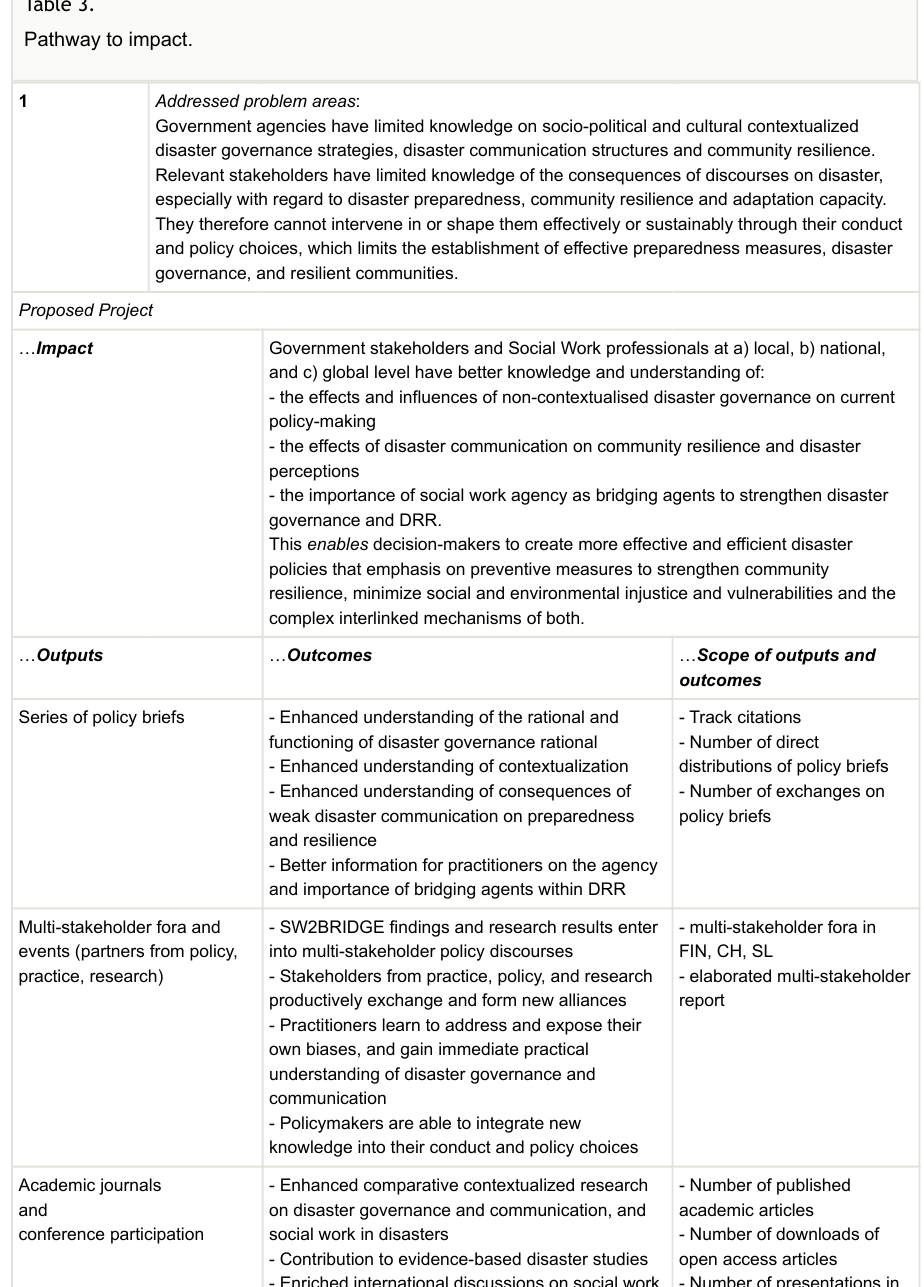
Pathway to impact. Addressed problem areas : Government agencies have limited knowledge on socio-political and cultural contextualized disaster governance strategies, disaster communication structures and community resilience. Relevant stakeholders have limited knowledge of the consequences of discourses on disaster, especially with regard to disaster preparedness, community resilience and adaptation capacity. They therefore cannot intervene in or shape them effectively or sustainably through their conduct and policy choices, which limits the establishment of effective preparedness measures, disaster governance, and resilient communities.